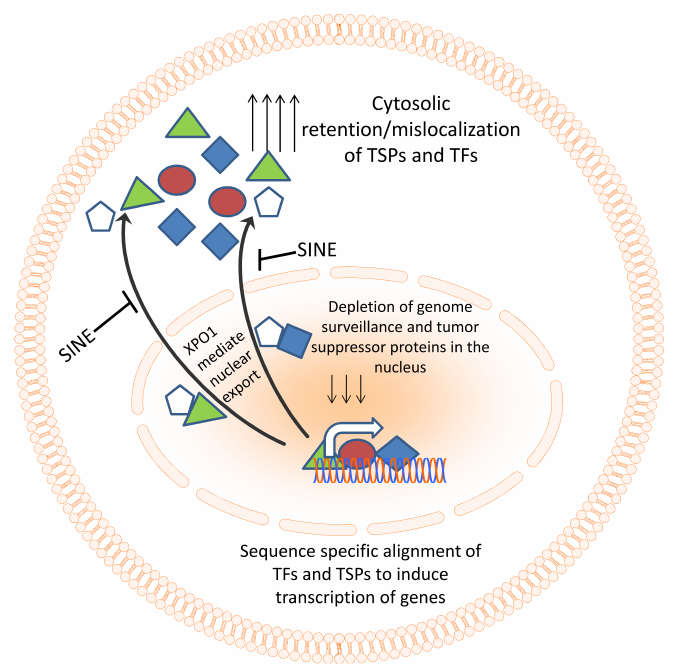
Figure 2. Nuclear export machinery as a therapeutic target. Genome surveillance and tumor suppressor proteins need to align to DNA in a sequence-specific manner in order to coordinate their surveillance and tumor suppressive function. In cancer, the excessive export of these TSPs results in their accumulation in the cytosol and functional inactivation. Specific inhibitors of nuclear export (SINE) compounds can block the nuclear export and restore TSPs in the nucleus of cancer cells leading to activation of tumor suppressive